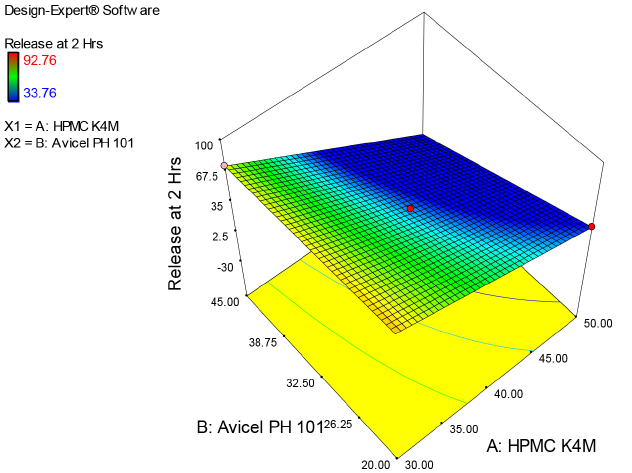
FIGURE 6a - Response surface model (RSM) showing effect of independent variables HPMC K100M and Avicel pH 101 on Disintegration